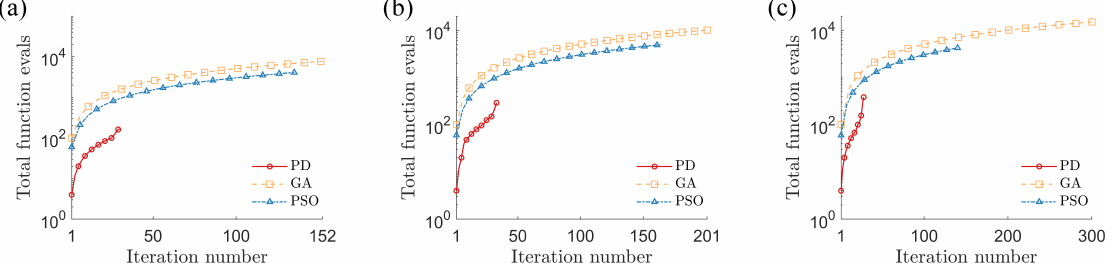
Figure 4. Computational effort (cumulative number of function evaluations) required to identify parameters for three van der Pol–Duffing oscillators: ( a ) single-well, ( b ) double-well, and ( c ) double-hump. Table 2. Performance of optimization strategies for the van der Pol–Duffing oscillator using proportional–derivative controller (PD), genetic algorithm (GA), and particle swarm optimization (PSO)